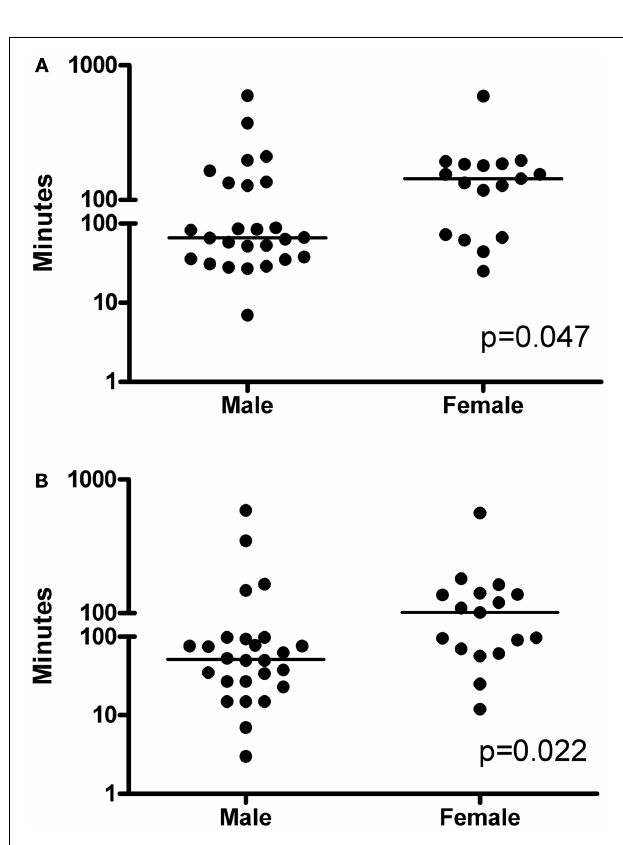
FIGURE 3 | Gender differences in (A) time from triage to antibiotics ( p = 0.047) and (B) time from seeing the physician to adequate antibiotics ( p = 0.022) . Statistically significant differences between the groups were determined by the non-parametric Mann–Whitney U test. A two-tailed p -value < 0.05 was considered statistically significant and the p -values are indicated. Horizontal lines denote median